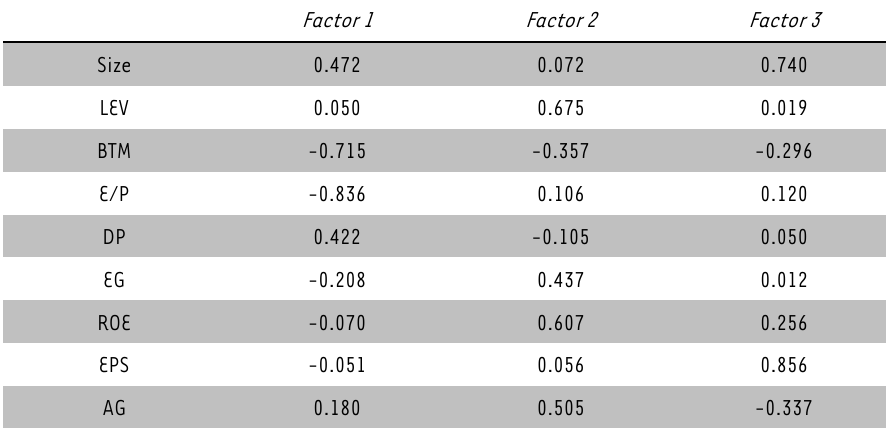
TABLE 2: Factor loadings (varimax